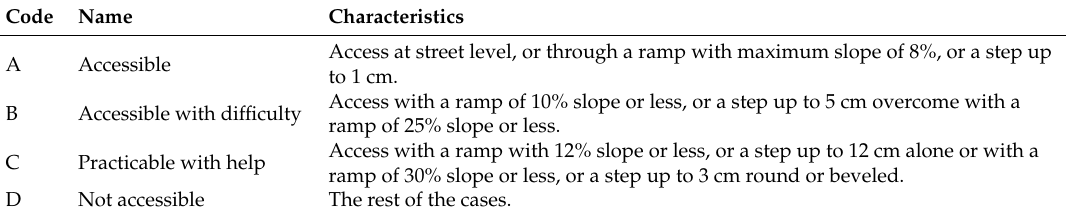
Table 1. Summary of the levels of accessibility to the buildings defined in this research.